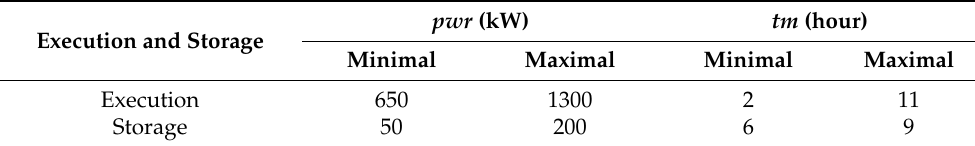
Table 3. Power and time distribution of an execution and a storage.